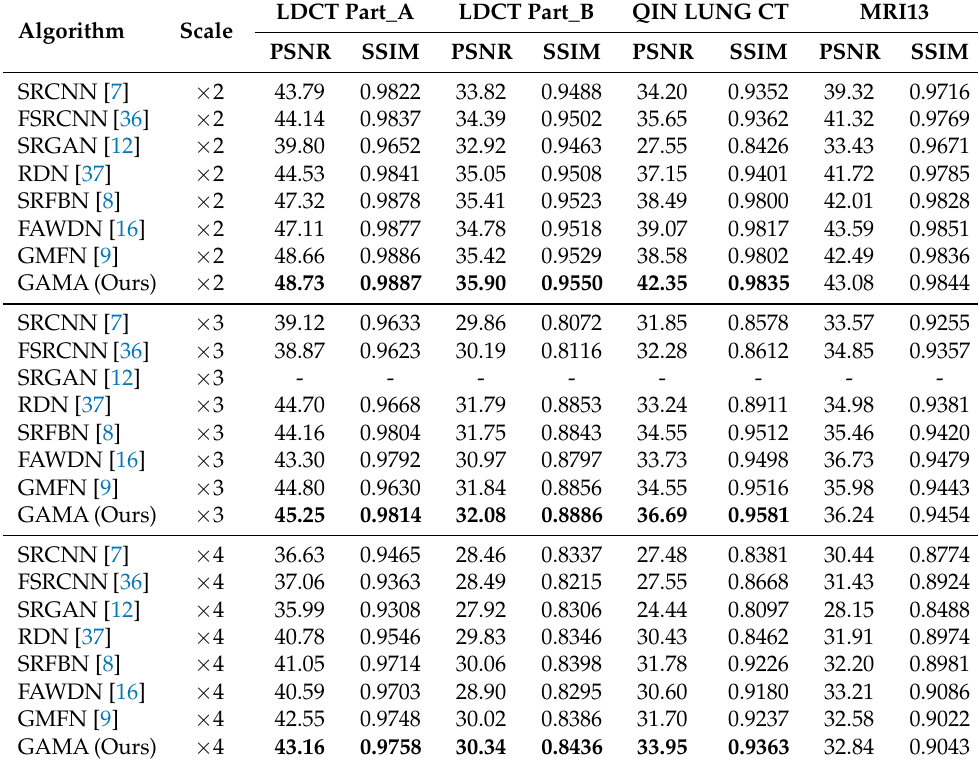
Table 1. Comparative results on the LDCT Part_A, LDCT Part_B [30], QIN LUNG CT [31], and MRI13 [32] datasets. The best results are highlighted in bold